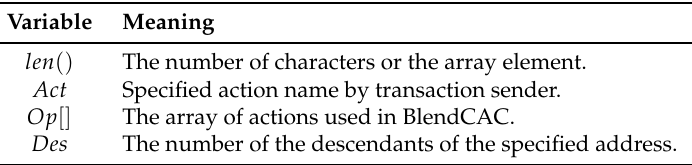
Table 3. Variables in Measurement of Gas.